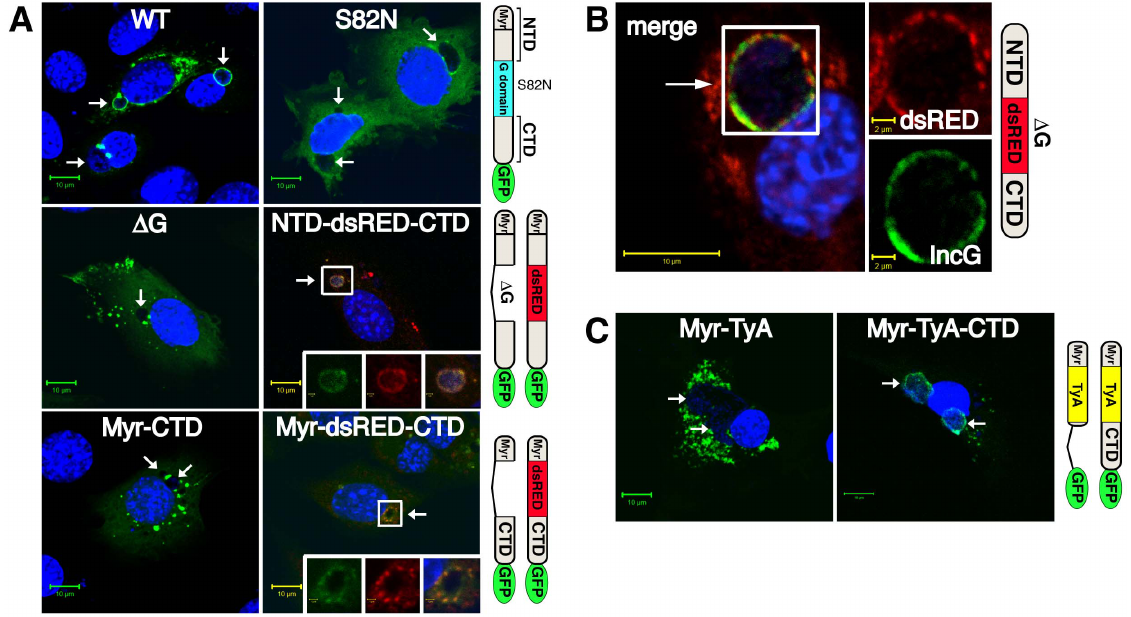
Figure 1. Oligomerization of the N- and C-terminus of Irgb10 is sufficient to target GFP-fusion proteins to C.trachomatis inclusions. ( A and C ) The indicated GFP fusion proteins were ectopically expressed in wildtype MEFs. Transfected cells were then infected with C. trachomatis and treated with IFN c at 3 hpi. Cells were fixed and stained for DNA with Hoechst at 20 hpi. Arrows point at Hoechst-positive inclusions. ( B ) Cells were transfected with NTD-dsRED-CTD lacking a GFP moitety, infected with C. trachomatis and stained with anti-IncG.